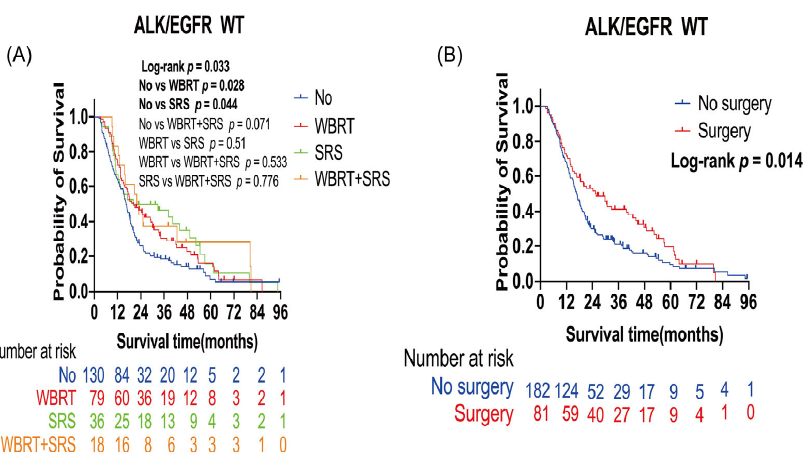
Figure 2. Kaplan–Meier overall survival curves of patients with lung cancer brain metastases with the ALK/EGFR wild type: ( A ) Kaplan–Meier OS curves according to radiotherapy; ( B ) Kaplan–Meier OS curves according to surgery. Plot symbols at both events and censored cases. SRS, stereotactic radiosurgery; WBRT, whole brain radiotherapy; WT, wild type; ALK, anaplastic large-cell lymphoma kinase; EGFR, epidermal growth factor receptor. Table 3. Univariate and multivariate analyses of risk factors for OS in lung cancer BMs patients with the ALK/EGFR wild type.